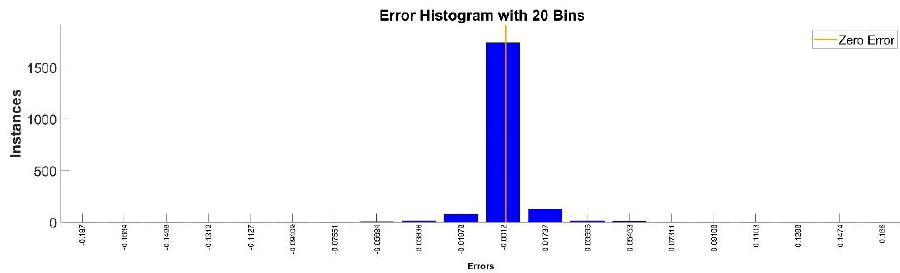
Figure 29. Relative errors between the target values and the predicted values for 𝑞 6 .